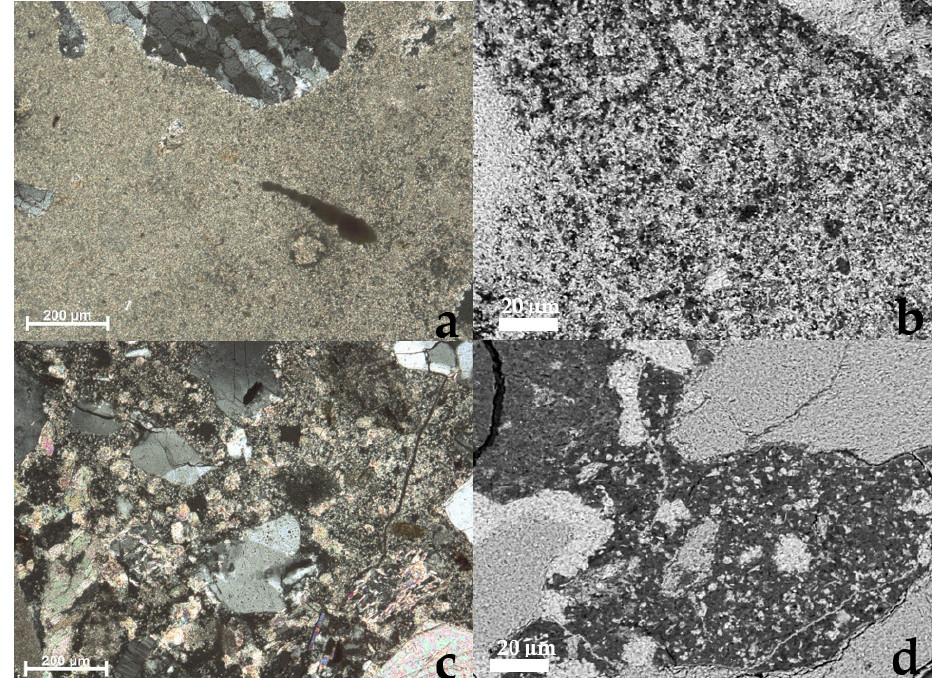
Figure 1. Microphotographs of air hardening calcitic lime binder: ( a ) micritic texture under PLM, xpl, and ( b ) SEM image at high magnification (dome of the Florence Cathedral (15th century)); ( c ) sparitic texture under PLM, xpl, and ( d ) SEM image at high magnification (Medici Fortress of San Martino in San Piero a Sieve (Mugello, Tuscany, 16th century). The length of the bar in the SEM images is 20 µ